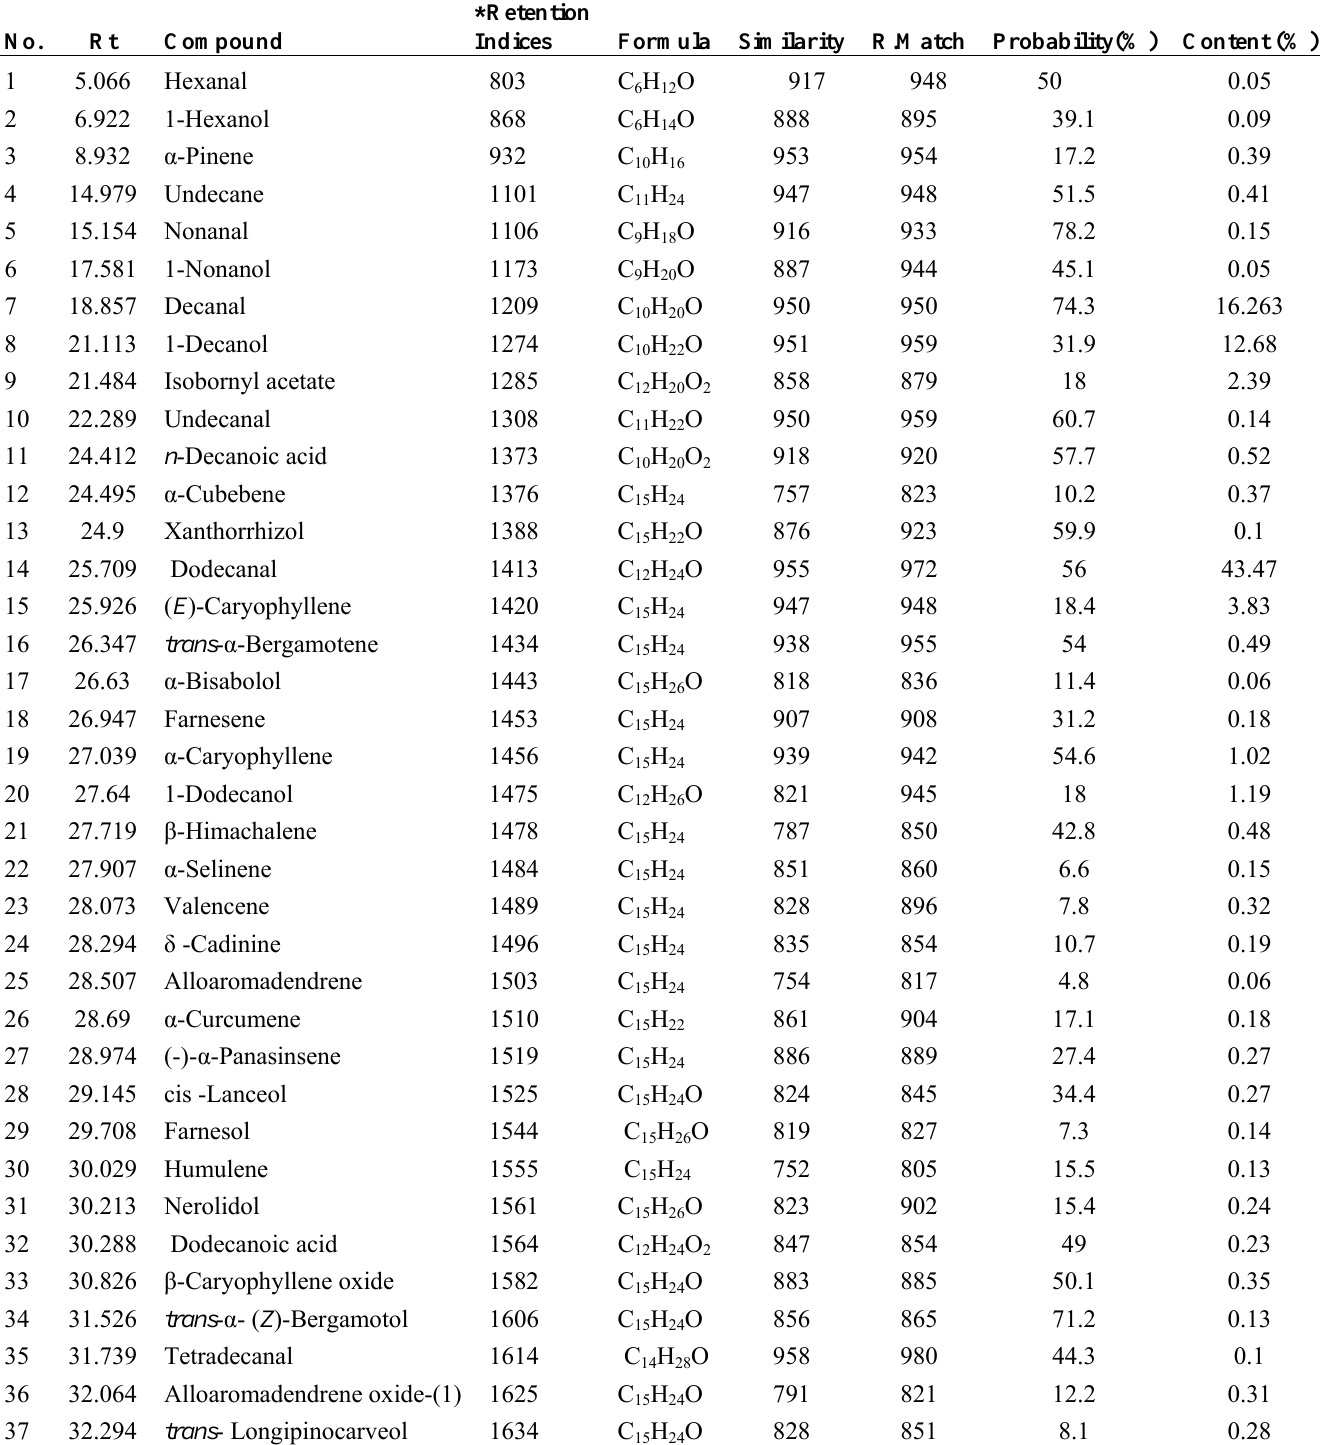
Table 1. Compounds identified in the essential oil of kesum using gas chromatography mass spectrometry